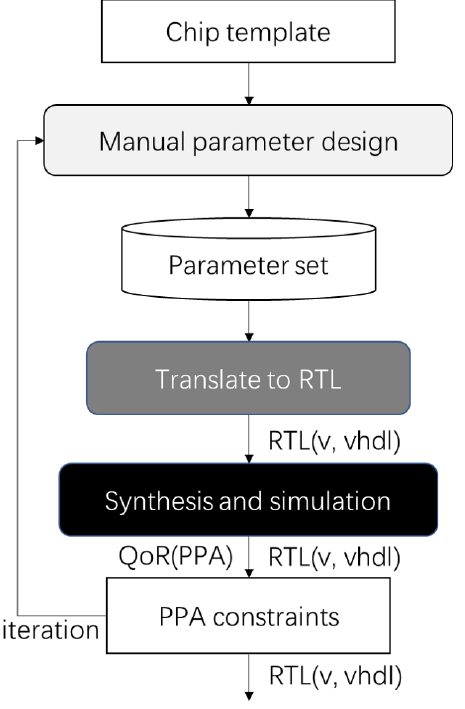
Figure 1. The parameter design process.